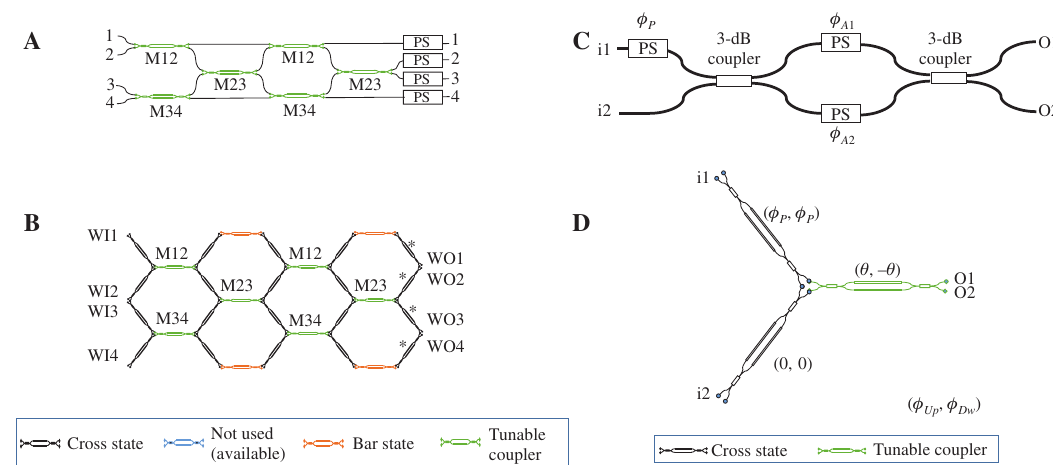
Figure 7: Layout and emulation using the hexagonal waveguide mesh of a rectangular 4 × 4 interferometer. (A) Rectangular arrangement of a 4 × 4 interferometer and (B) equivalent implementation using the hexagonal waveguide mesh. (C) MZI and phase shifter arrangement proposed in Ref. [14] for the implementation of the beam splitters in the rectangular arrangement. (D) Equivalent configuration for the MZI and phase shifter arrangement using the elements available in the hexagonal cell. ( ϕ lower phase shift applied to each TBU